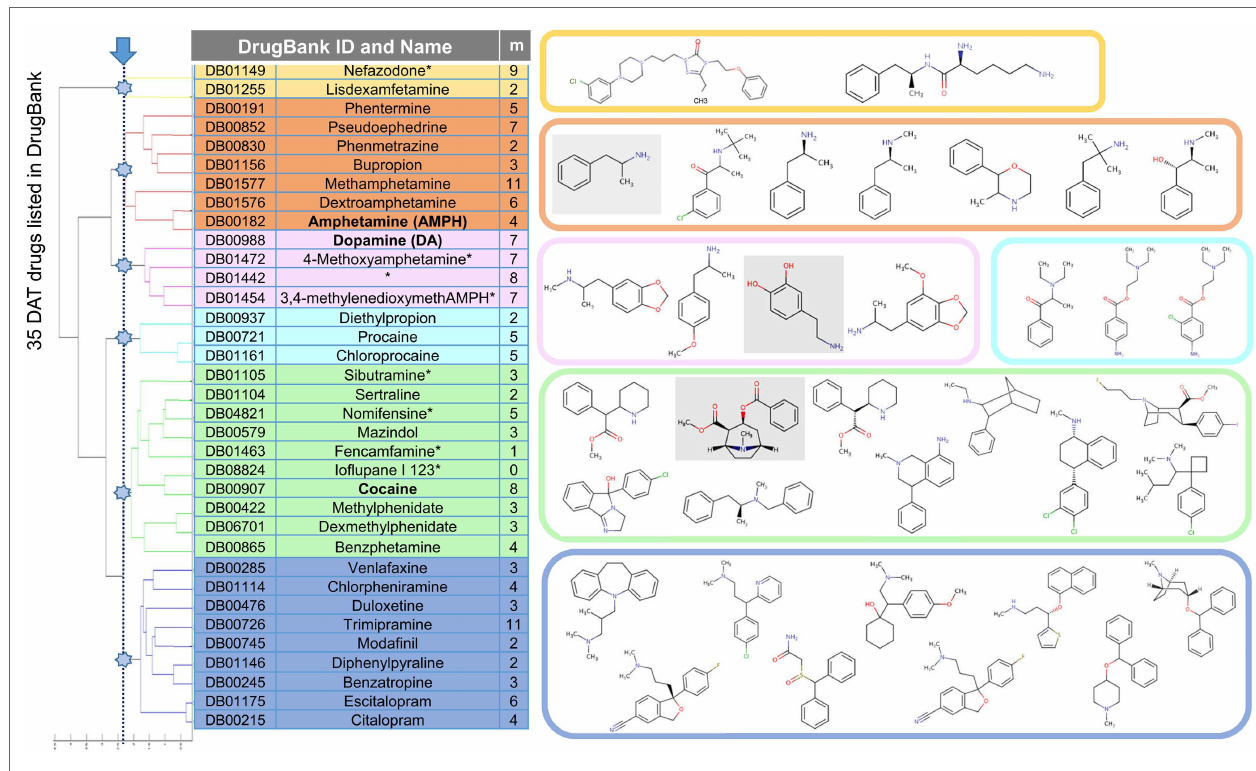
boxes on the right. The table contains, in addition to the DrugBank identifiers (first column) and names (second column; with asterisks indicating illicit or withdrawn drugs that have been removed from further analysis), the number of targets (third column) listed (in DrugBank) for each